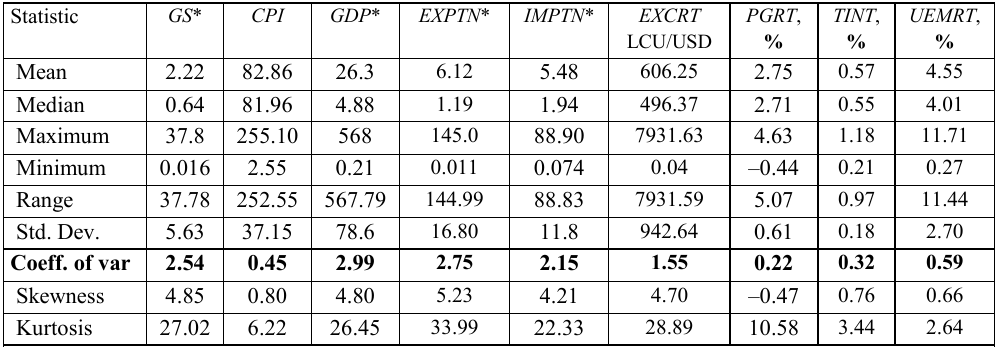
Table 1. Descriptive Summary of the Study